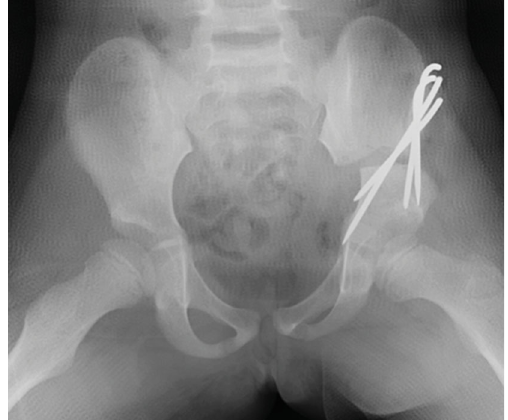
Figure 2: Radiograph of the hips just after Salter innominate